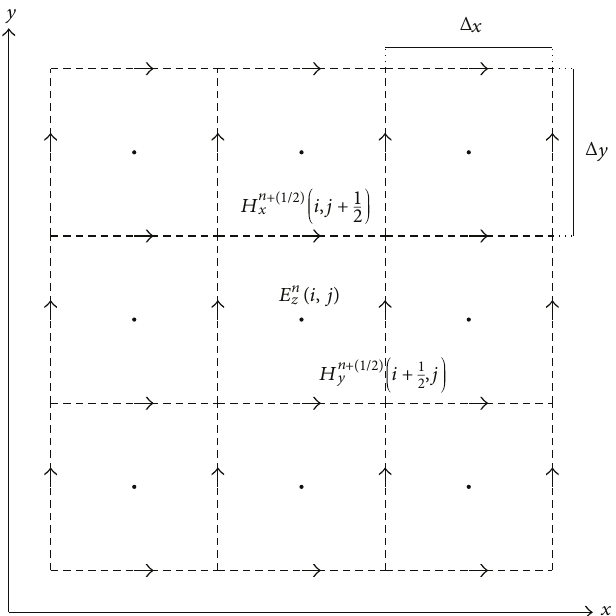
Figure 2: Generic Cartesian spatial cell ( i , j ) and surrounding cells in the 2D computational domain. Stored values for each cell are the z -component of the electric fi eld at time n and position ( i , j ), the x -component of the magnetic fi eld at time n +1/2 and position ( i , j + 1/2), and the y -component of the magnetic fi eld at time n +1/2 and position ( i +1/2, j ).